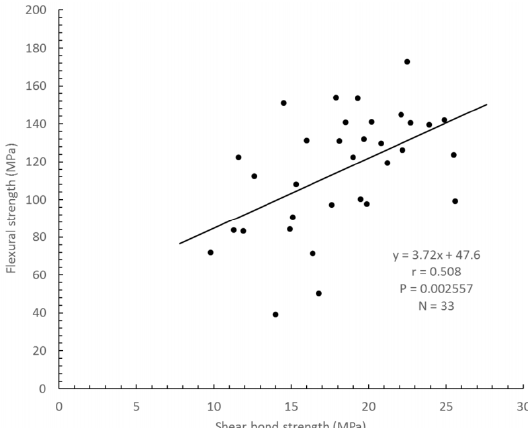
Figure 2. Relationship between flexural strength and root dentin shear bond strength dentin (r = 0.508, p = 0.0026, n = 33).